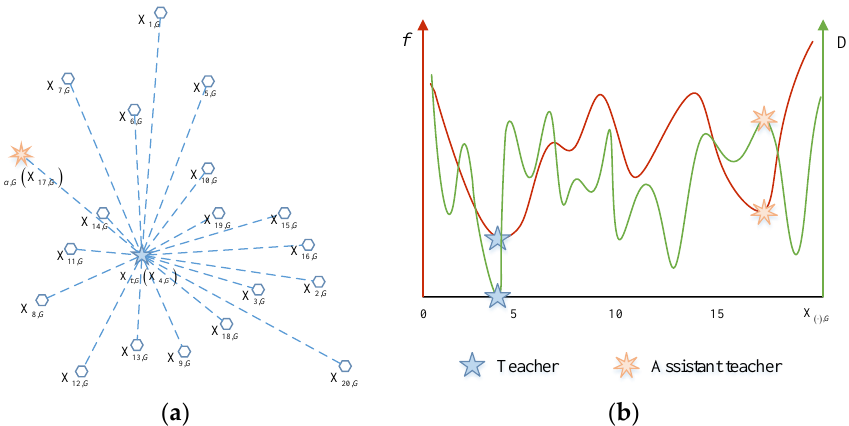
Figure 7. Example of fitness-distance ranking ratio. ( a ) Individual position distribution; ( b ) Fitness and distance distribution between teachers and assistant teachers.